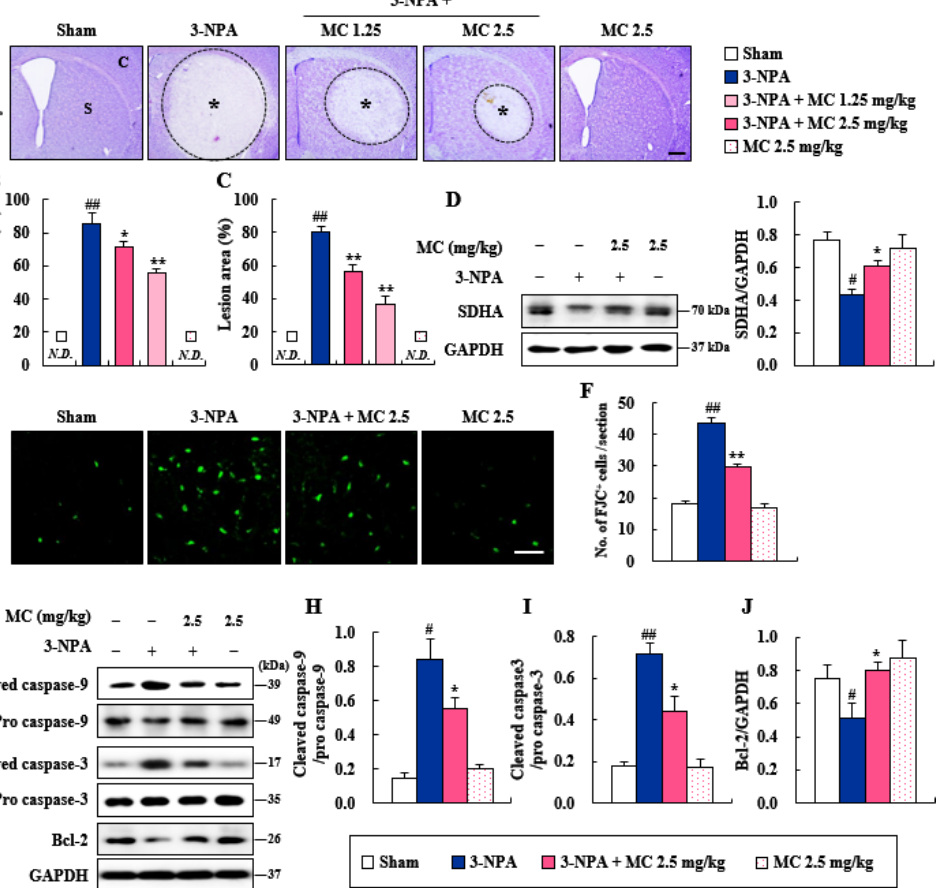
Figure 2. MC prevents neurodegeneration and apoptosis in the striatum after 3-NPA treatment. ( A – F ) At 24 h following the last (5th) 3-NPA treatment, striata from sham ( n = 5), 3-NPA ( n = 5), 3-NPA + MC (2.5 mg/kg/day; n = 5), and MC (2.5 mg/kg/day; n = 5) groups were subjected to histopathological and Western blot analyses to investigate the effect of MC (2.5 mg/kg/day, i.v.) on striatal cell death and apoptosis. ( A – C ) Representative photographs showing the level of striatal lesion by cresyl violet staining ( A ). MC significantly reduced the number of mice with striatal lesion ( B ) and the lesion area ( C ). Asterisk, S, and C indicate striatal lesions, normal striatum, and normal cortex, respectively. Scale bar = 100 μm. N.D., not detected. Data are expressed as mean ± SEM (Kruskal – Wallis; # p < 0.05 and ## p < 0.01 versus sham group; * p < 0.05 and ** p < 0.01 versus 3-NPA group). ( D , F , G ) Striata from all groups were analyzed by Western blot to determine the expression level of SDHA ( D ), cleaved caspase-9 ( G , H ), cleaved caspase-3 ( G , I ), and Bcl-2 ( G , J ). MC prevented the enhancement of these protein expressions. ( E , F ) Representative photographs ( E ) and quantified graph ( F ) showing the level of striatal cell death by FJC staining. MC significantly reduced the number of FJC (+) cells. Scale bar = 200 μm. Data are expressed as mean ± SEM ( Kruskal – Wallis; ## p < 0.01 versus sham group; * p < 0.05 and ** p < 0.01 versus 3-NPA group).